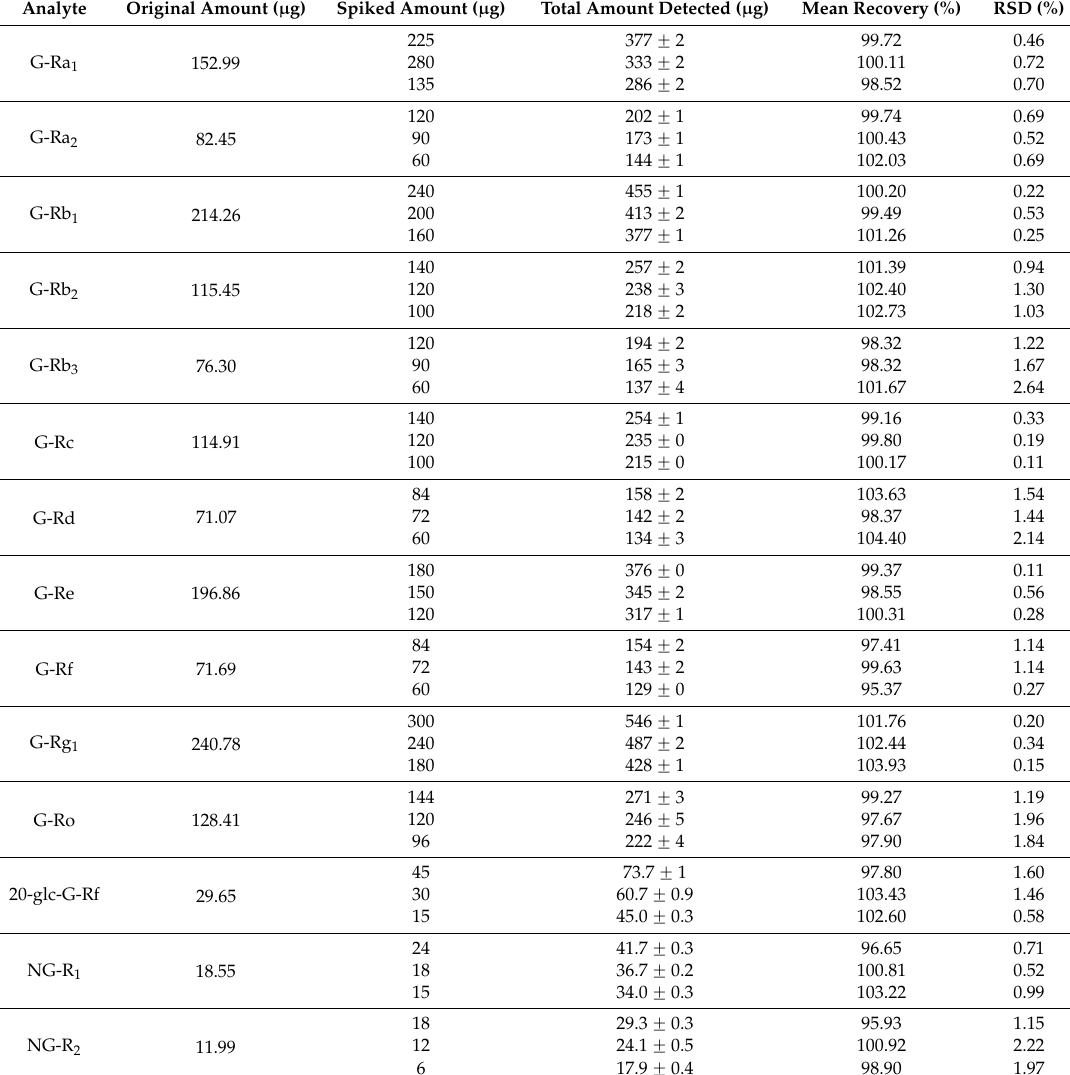
Table 2. The recoveries of 14